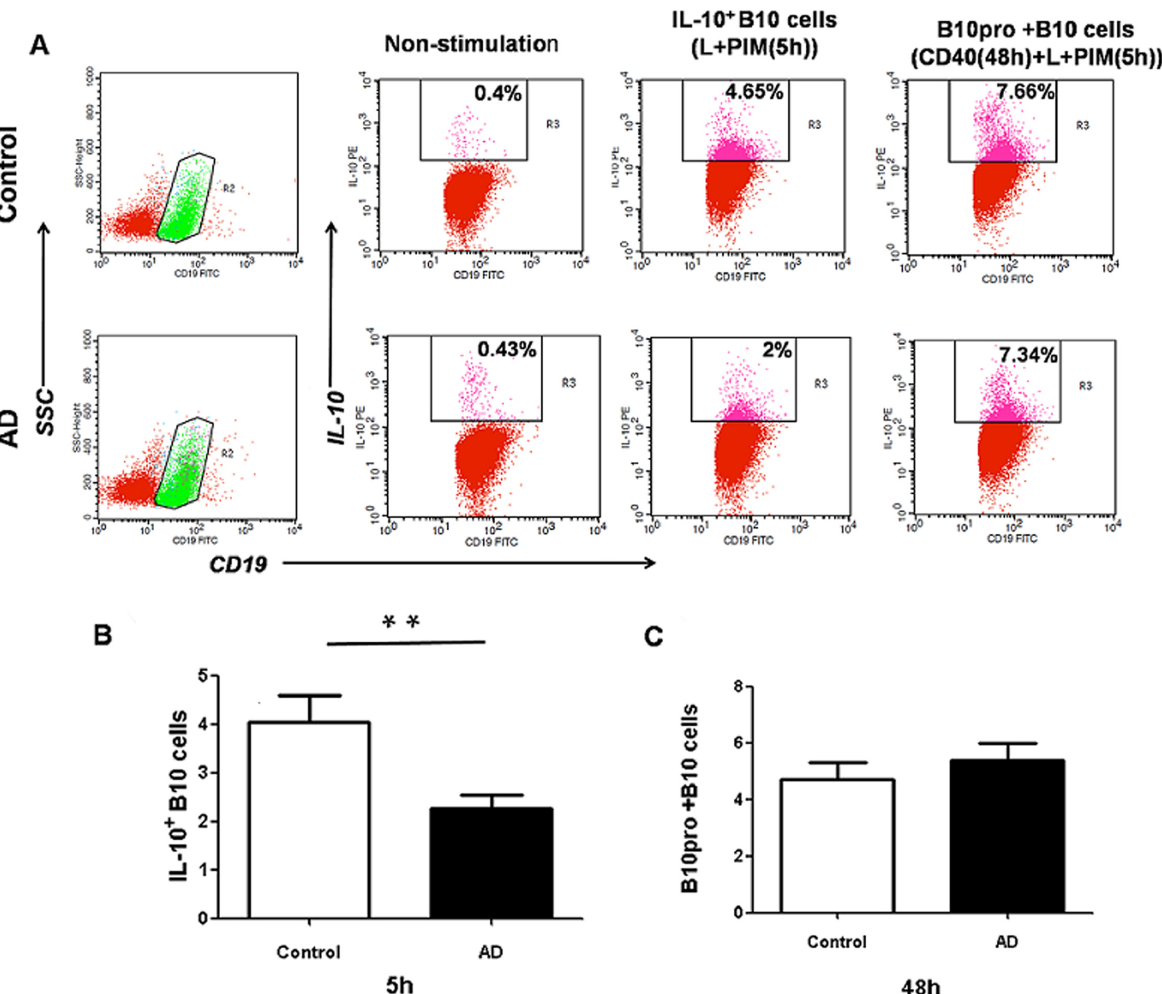
Fig 2. Comparison of IL-10 production in CD19 + B cells of AD mice and control. The B10 cells in the spleen of control (n = 10) or AD mice (n = 10) were in vitro stimulated for 5h or 48h withLPS(10 μ g/mL),PMA (50ng/mL), iono(500 ng/mL),monensin (2 mM), and CD40(1 μ g/mL). The number of CD19 + IL-10 + B cells wasmeasured by flow cytometry by using intracellular cytokine staining. (A) Representative comparative phenotype of CD19 + IL-10 + B cells from a control and AD mouse at 5 h and 48 h of stimulation; (B) The mean ( ± SEM) frequency of CD19 + B cells in PBMCs of spleen between controland AD groups after cultured for 5 h; (C) The mean ( ± SEM) frequency of B10pro+B10 cells in PBMCs of spleen between control and AD groups after culturing for 48 h; Data are expressed as mean ± SEM. Data are expressed as mean ± SEM. ** P < 0.01, as analyzed by one-way ANOVA, followed by Tukey multiple-comparison